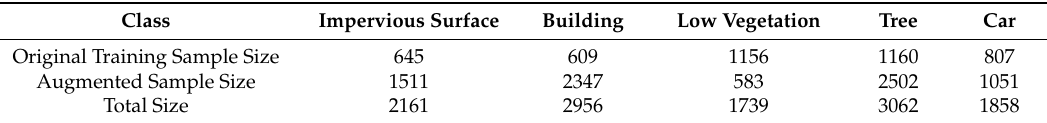
Table 9. Training sample size.